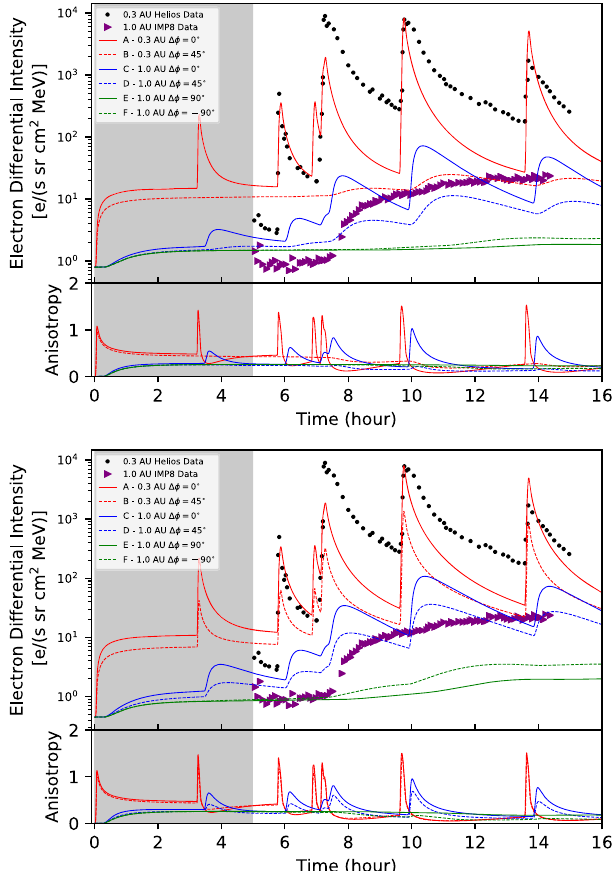
Fig. 5. Simulated omni-directional differential intensities and anisotropies for k r = 0.10 AU and an injection broadness of r = 5 (cid:3) (top panel) and r = 20 (cid:3) (bottom panel). Refer to text for a discussion regarding the gray shaded